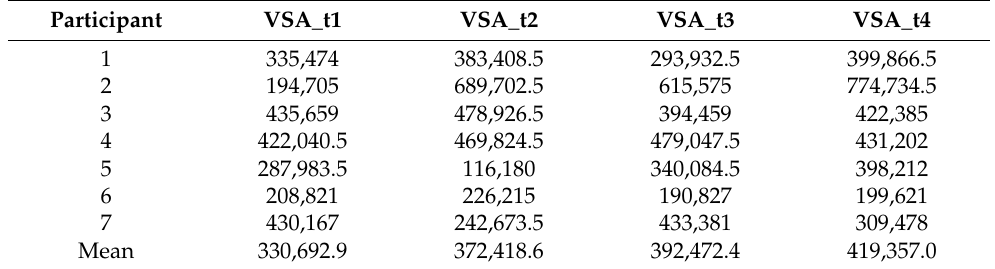
Table 14. VSA (Hertz, squared) individual and mean measurements at four assessment time points.